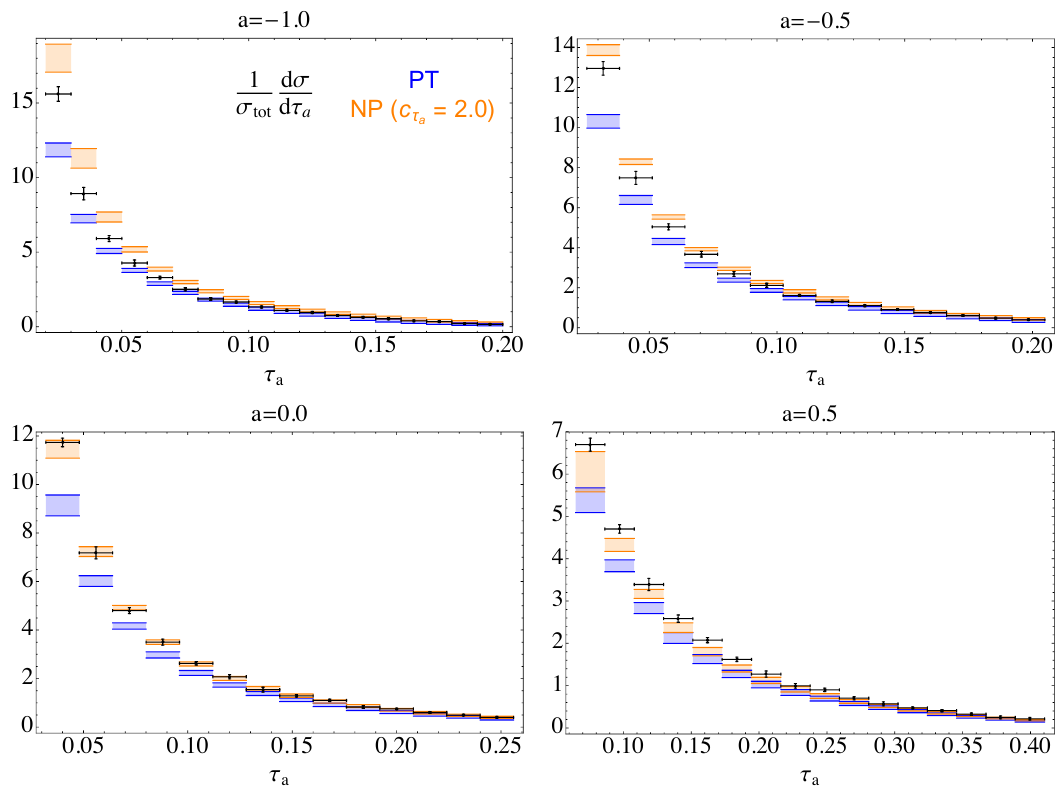
Figure 17 . The same as in (cid:12)gure 15 (for a = scaling coe(cid:14)cient purposefully altered to c (cid:28)